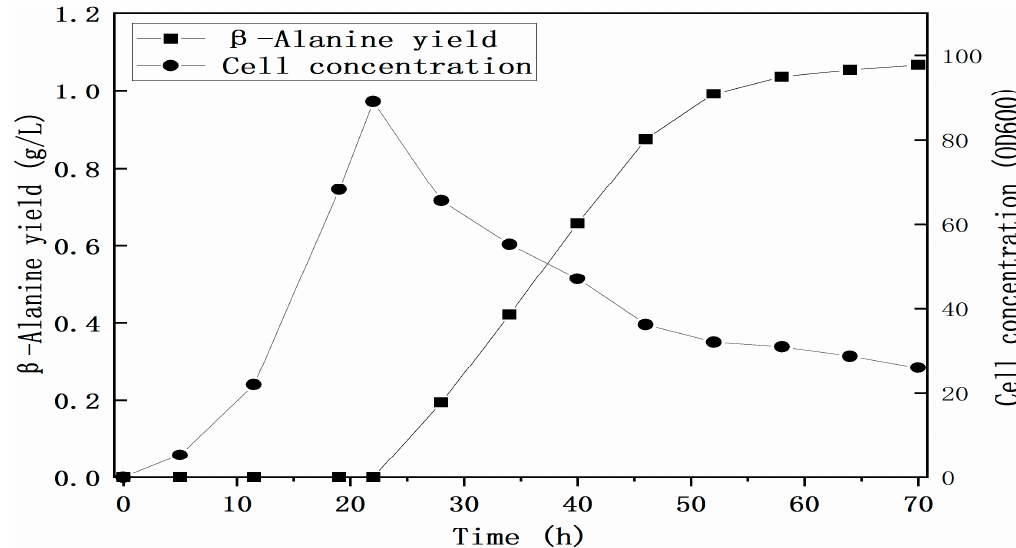
Figure 4. Profiles of growth and β -alanine production using strain B0016-200BB/pET24a- panD - AspDH in a 5-L bioreactor. During the fermentation of β -alanine production, genes were induced for expression with the addition of IPTG at 15 h, and oxygen-limited fermentation was conducted at 22 h.